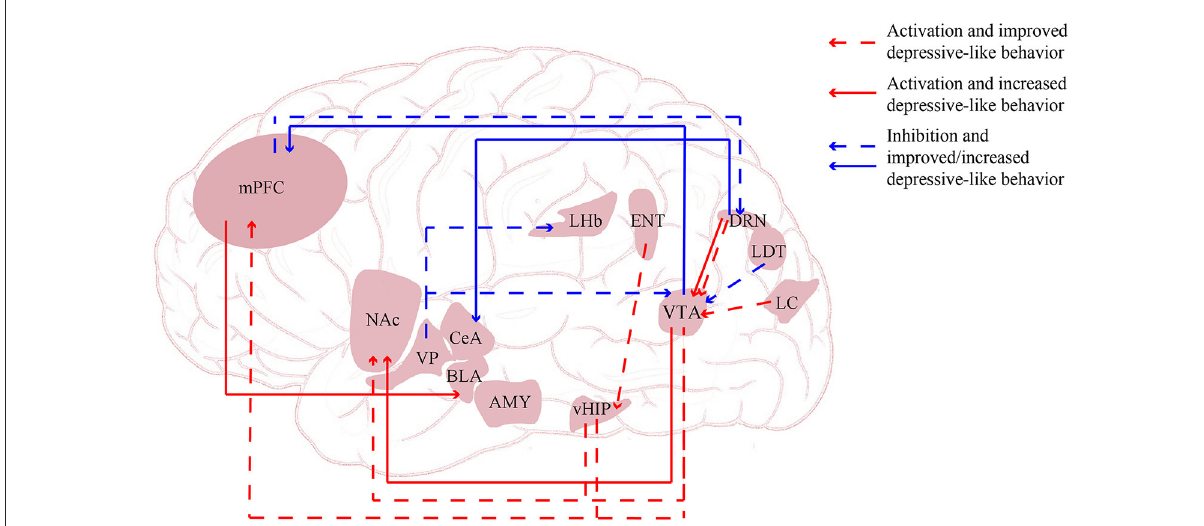
FIGURE2 Neural circuits regulated via optogenetics and chegenetics. AMY, amygdala; BLA, basolateral amygdala; CeA, central nucleus of the amygdala; DRN, dorsal raphe nucleus; ENT, entorhinal cortex; LC, locus coeruleus; LDT, lateral dorsal tegmentum; LHb, lateral habenula; mPFC, medial prefrontal cortex; NAc, nucleus accumbens; vHIP, ventral hippocampus; VP, ventral